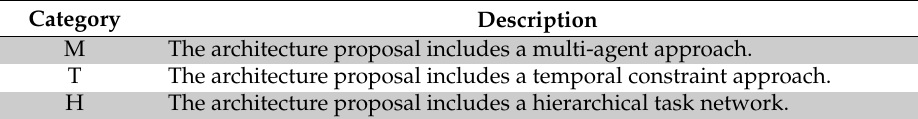
Table 2. Mission plan specification additional categories assessment (2nd